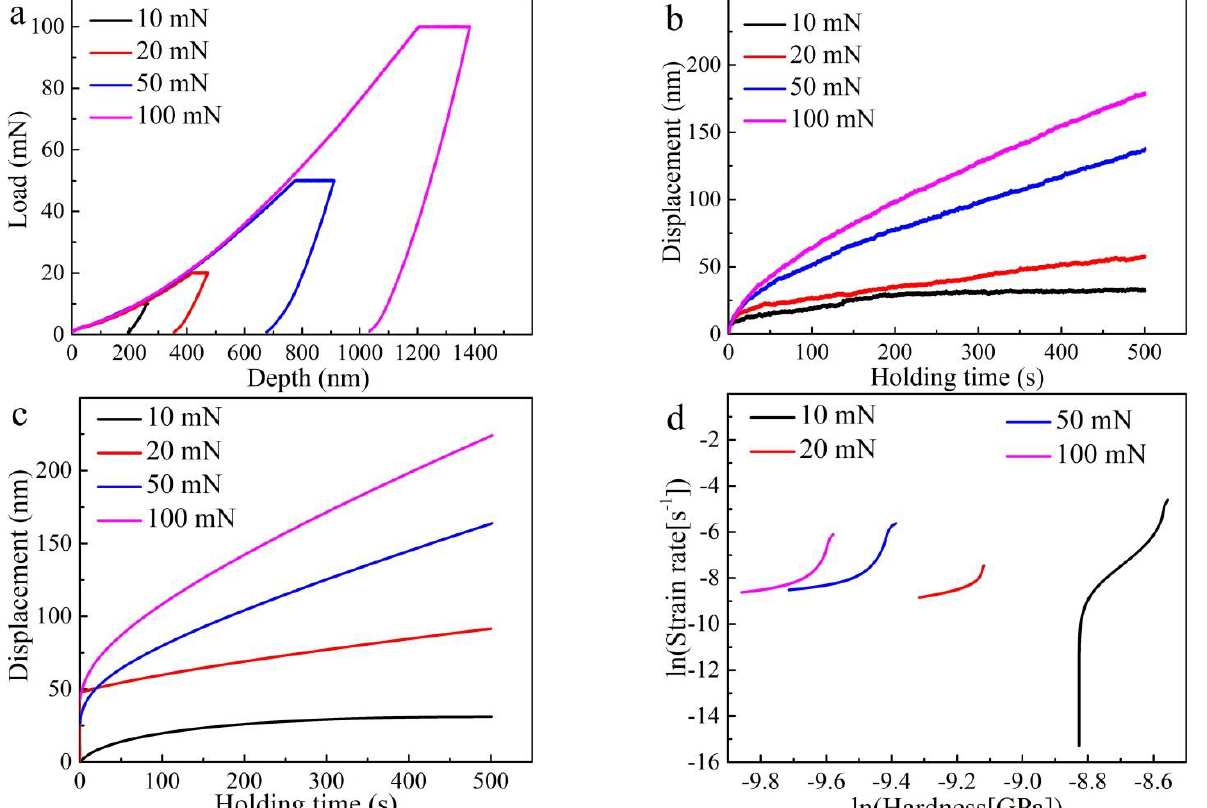
Figure 10. PBF-EB AM Ti6Al4V alloy with linear and 90° rotation scanning strategy (sample B): ( a ) P–h curves under various maximum loads (10–100 mN); ( b ) experimental and ( c ) fitting creep displacement–time curves under various maximum loads (10–100 mN); and ( d ) ln-ln plots of strain rate vs. nanoindentation stress under various maximum loads (10–100 mN).